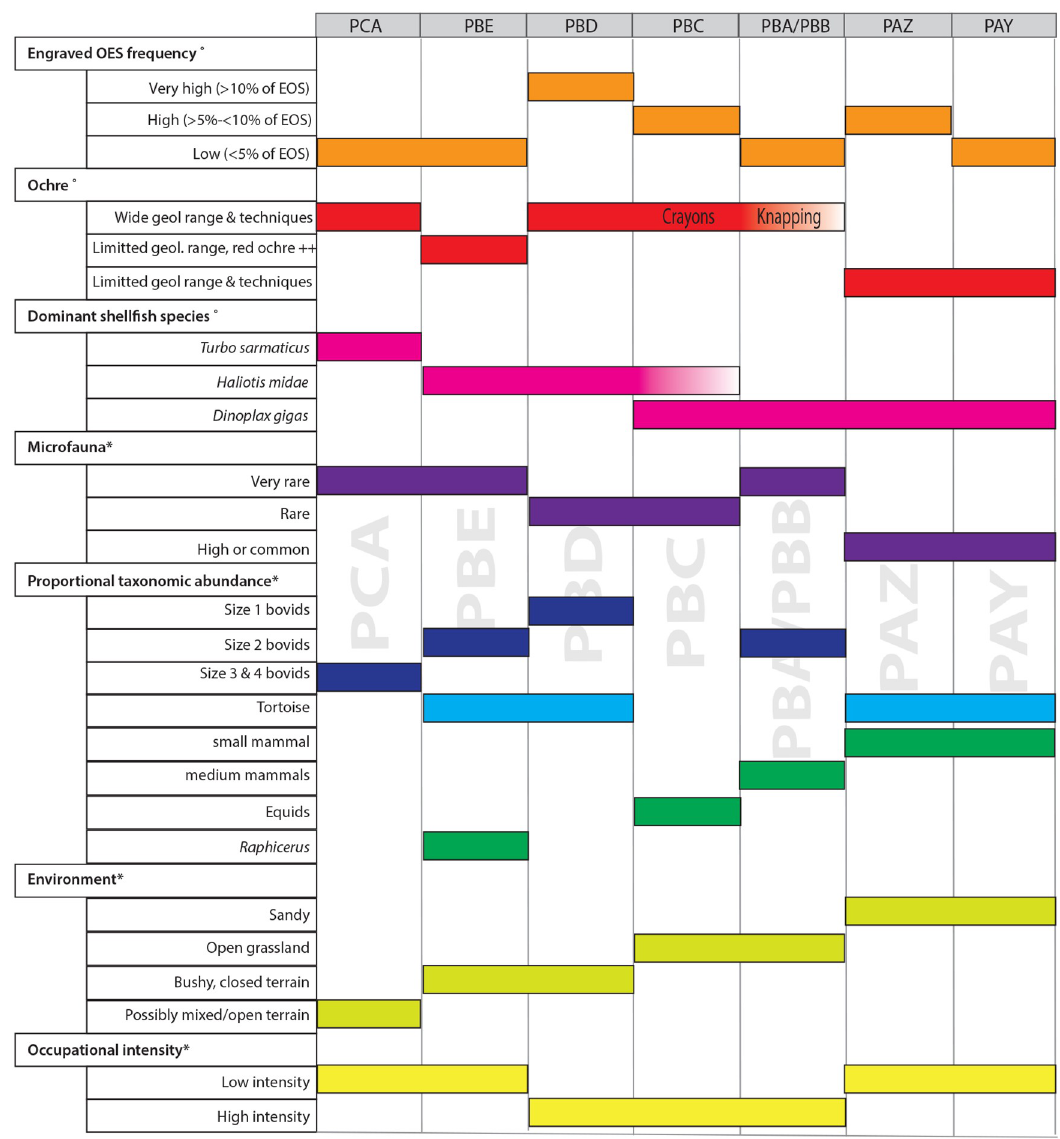
Fig 10. Synthetic representation of pattern of changes in non-lithic assemblage characteristics through the sequence. Proxies � : adapted from [43]. Proxies ˚: adapted from